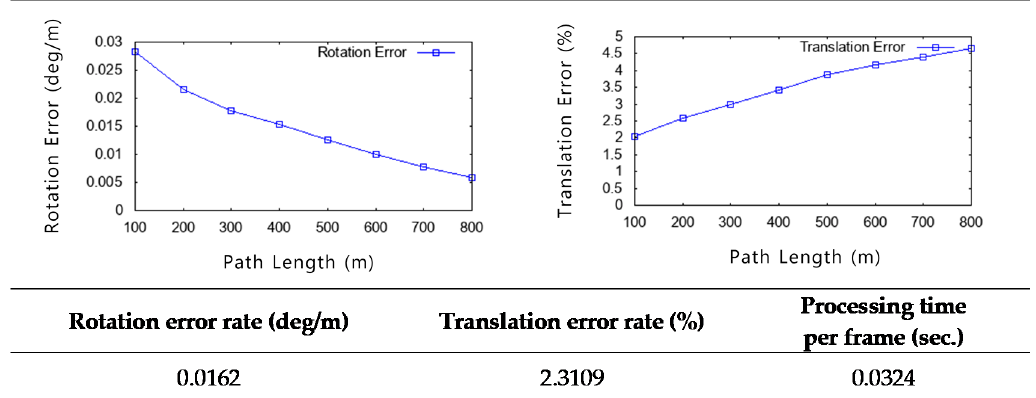
Figure 24. Graph of error over mileage for sequence 10.